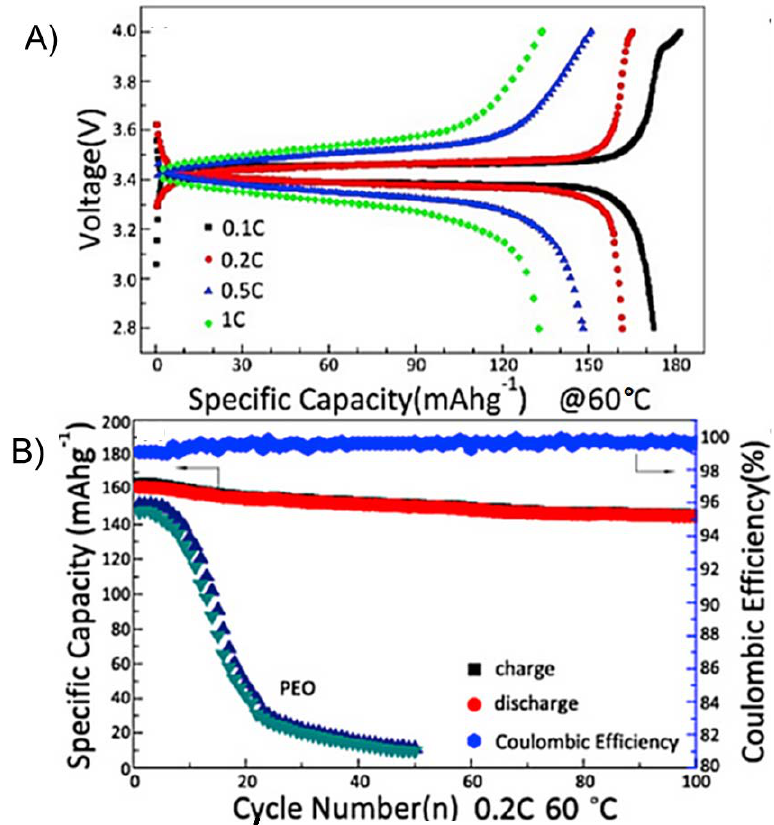
Figure 7. ( A ) Specific capacity of an NPEG-TMPEG polymer electrolyte-LFP cell at 60 ◦ C cycled at various rate between 2.8 and 4.0 V. ( B ) Capacity of the NPEG-TMPEG polymer electrolyte-LFP cell after 100 cycles at 0.2 compared with a PEO-LFP cell. Journal of Power Sources,